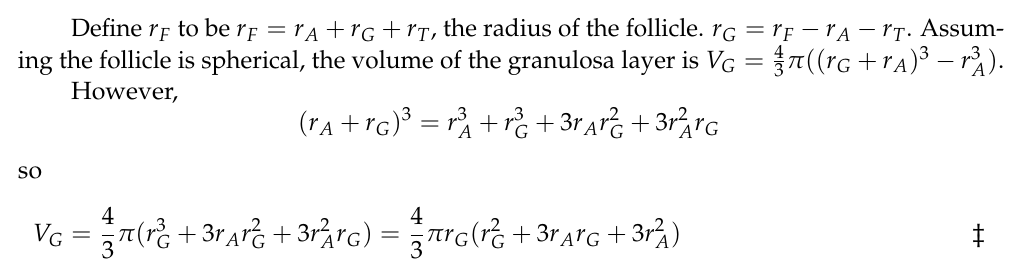
Figure 4. Cell number per volume of granulosa